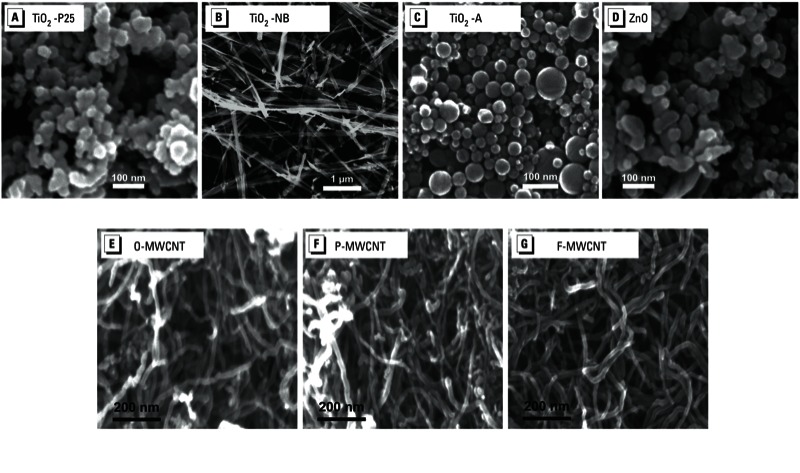
SEM images of ENMs: (A) TiO2-P25, (B) TiO2-NB, (C) TiO2-A, (D) ZnO, (E) O-MWCNT, (F) P-MWCNT, and (G) F-MWCNT.